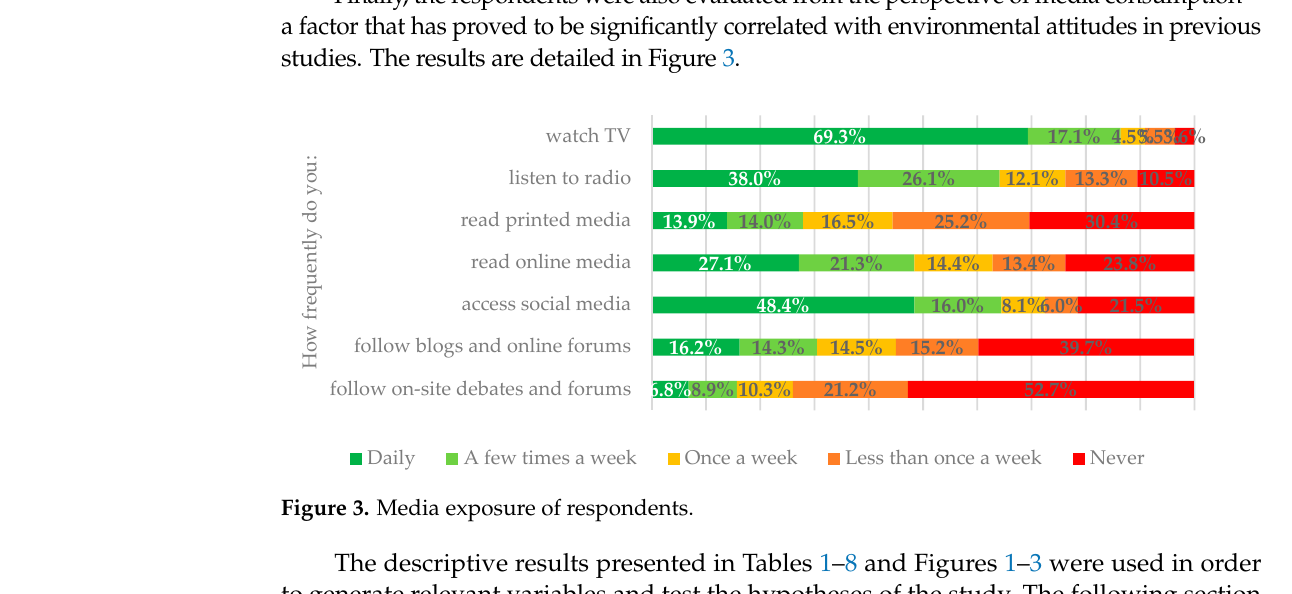
Table 9. Results of the ordinal logistic regression. Q: From your point of view, should Romania give up on traditional electricity production (coal, fossil, etc.) and move towards production based on renewable energy sources (wind, photovoltaic, biomass)? Parameter